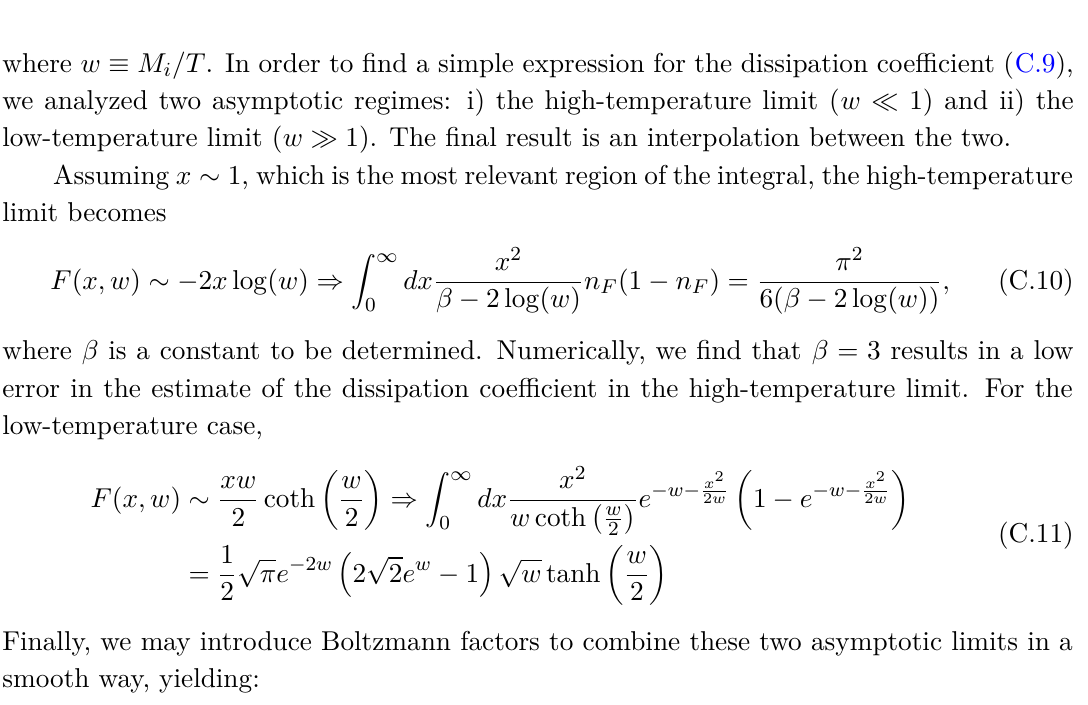
Figure 8 . Numerical evaluation of the integral in (C.9) and its analytical approximation, Υ i /B with B = T cos 2 ( δ ) V 2 /y 2 i